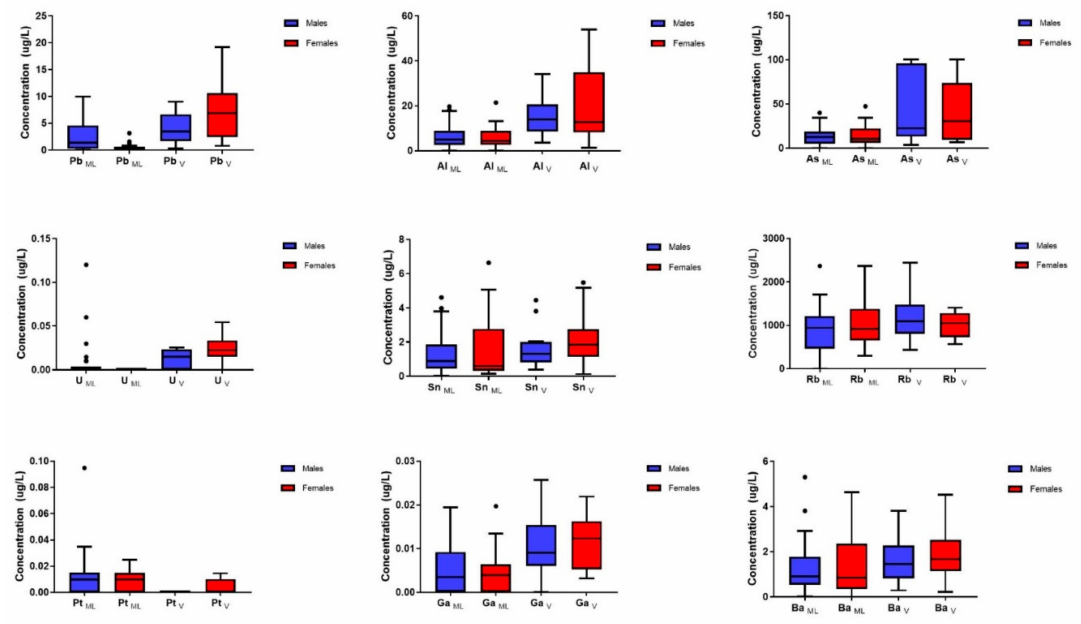
Figure 3. Box plots for toxic metal concentrations in the urine of subjects after chelation therapy, using gender comparison between Main Island and Vieques population. The boxes represent the first and third quartiles (inner quartile range; IQR), and the inside line represents the median. The whiskers represent the lowest and highest value within 1.5 times the IQR. Dots represent